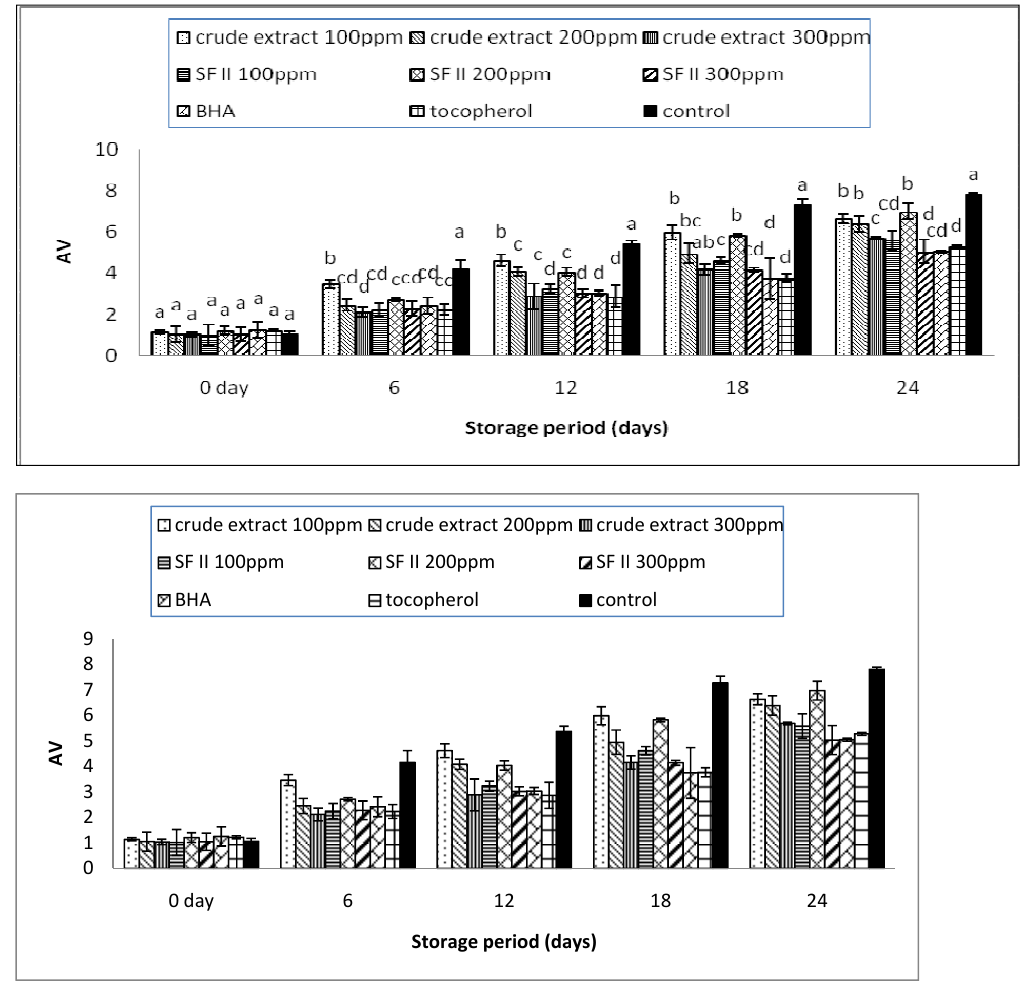
Figure 2. The p -anisidine (AV) value of the supplemented sunflower oil with rambutan extracts, BHA and Tocopherol under accelerated storage at 65 °C for 24